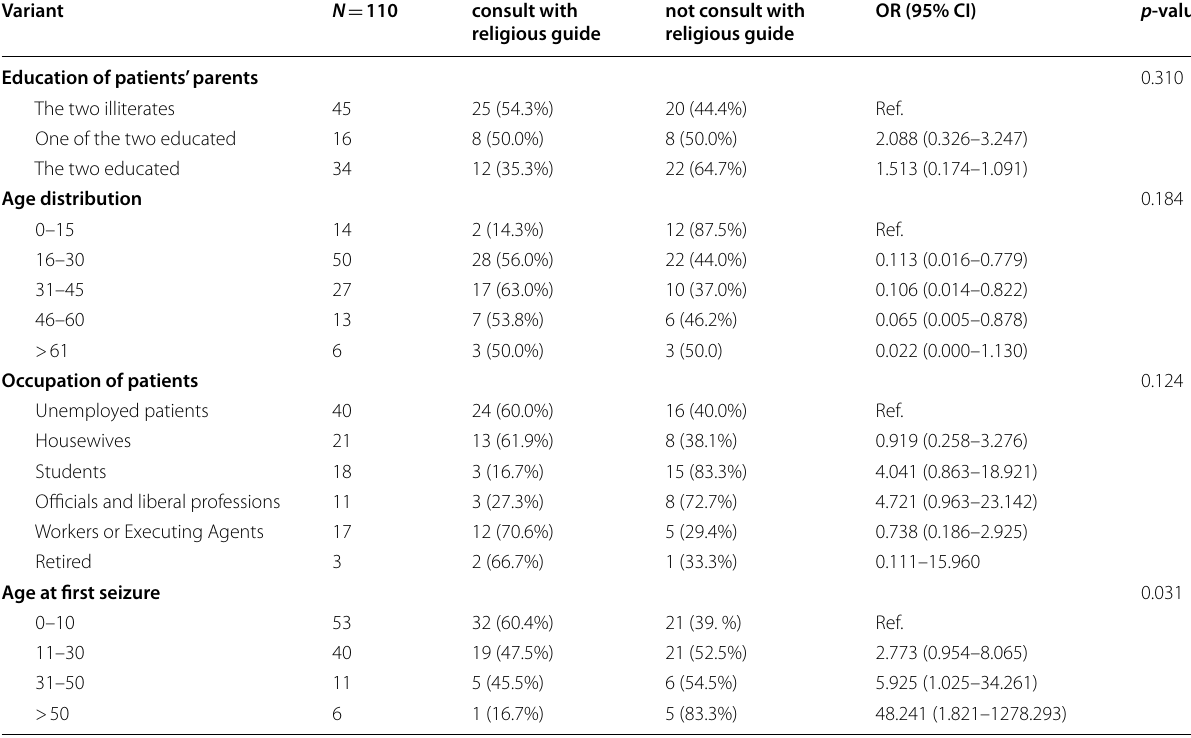
Table 4 Variables of the model of binary logistic regression and socio-demographic and cultural characteristics associated with to first